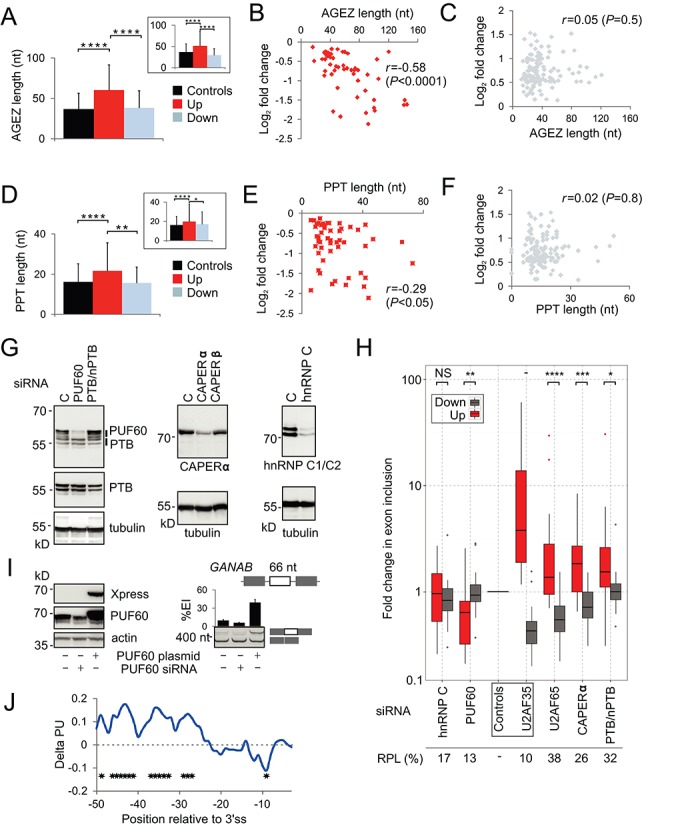
Structural and functional characterization of U2AF(35)-dependent 3′ss. (A, D) AGEZ (A) and PPT (D) length of alternative 3′ss (inset) and internal exons affected by U2AF35 depletion. Columns show means, error bars denote SDs. The number of each event is in the legend to Supplementary Figure S8. PPT length was computed for BPs with the highest SVM scores (41). P-values were derived from t-tests; ****P < 0.00005; **P < 0.005. AGEZ and PPT length correlated with the expression change of upregulated (B, E) but not downregulated (C, F) exons; r, Pearson correlation coefficient. (G) Immunoblots prepared from lysates from HEK293 cells depleted of poly(Y)-binding proteins (indicated at the top). Antibodies are shown at the bottom or to the right. (H) Functional antagonism and synergism of Y-binding proteins and U2AF. Exon inclusion levels of each transcript are in Supplementary Figure S11; RT-PCR primers are in Supplementary Table S4. Residual protein levels (RPL) were estimated from immunoblots shown in panel G. The Y-axis is on a log10 scale. Average changes between inclusion levels of upregulated and downregulated exons were compared by the Wilcoxon-Mann-Whitney test (*P < 0.05; **P < 0.005; ***P < 0.0005; ****P < 0.00005; NS: not significant; -: not tested). (I) Opposite effects of PUF60 depletion and overexpression on a GANAB exon. Immunoblots with the indicated antibodies are to the left and RT-PCR to the right. The GANAB minigene is schematically shown at the top; alternative exon is denoted by a white rectangle. Exogeneous RNA products were amplified by primers PL3 and PL4. Error bars are SDs of duplicate transfections. (J) Positional differences in unpaired probabilities upstream of U2AF(35)-activated and repressed exons. Positive delta PU values signify a higher average single-strandedness of upregulated exons in the optimal BP location and further upstream as compared to downregulated exons whereas negative values reveal their tendency to engage in local base-pairing interactions closer to 3′ss. Stars denote positions with P-values <0.05.